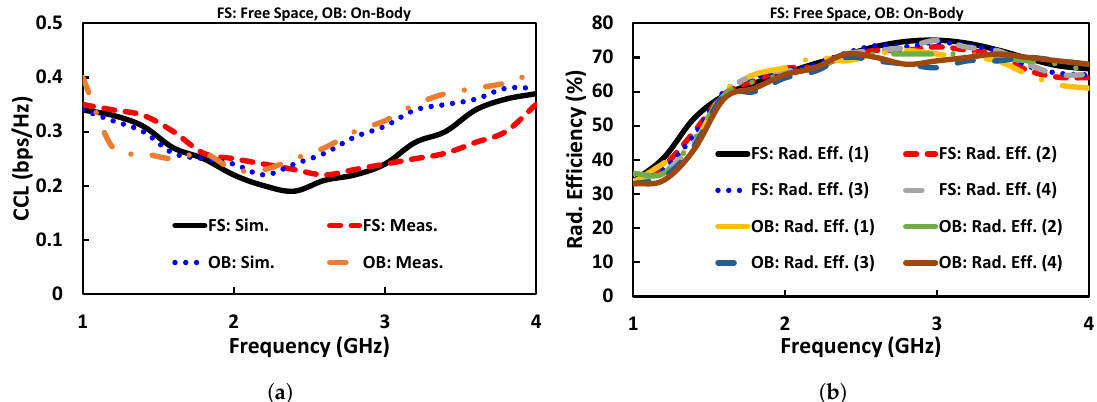
Figure 14. ( a ) The channel capacity loss (CCL) and ( b ) radiation efficiencies of the proposed